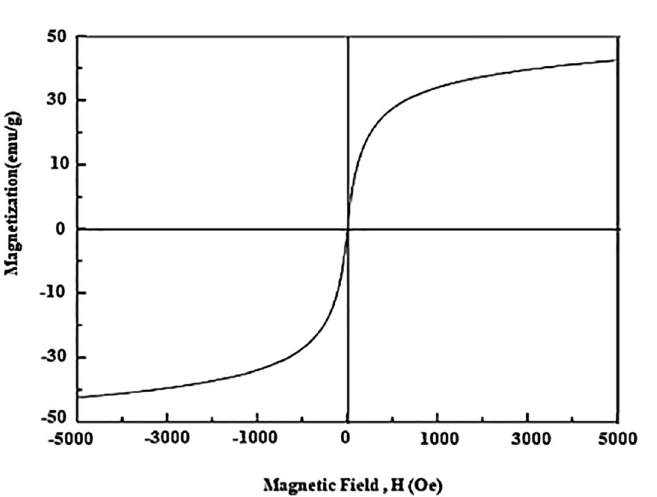
Figure 9. VSM curves of the as-synthesized nanomaterial.